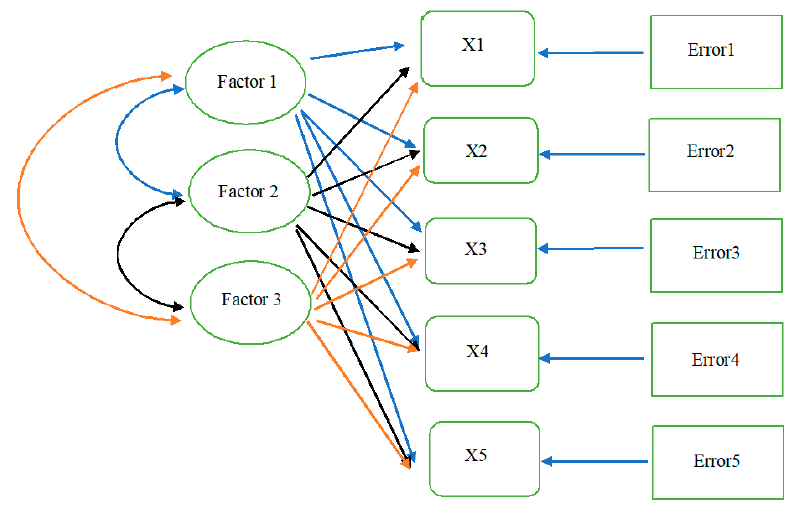
Figure 2. The exploratory factor analysis (EFA) model.